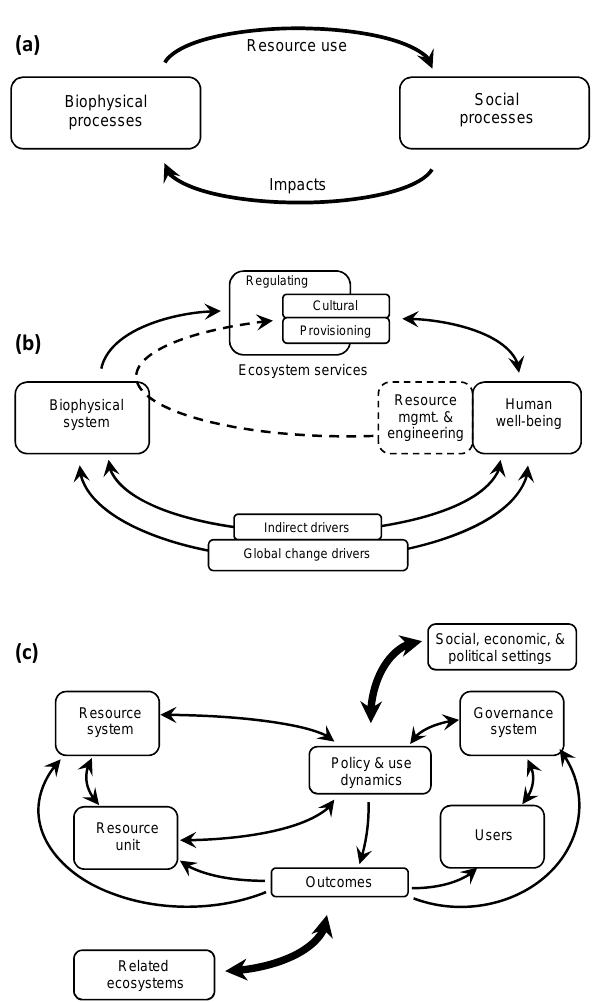
Fig. 1. Schematic diagrams of coupled human-environment sys- tems, illustrating feedback among components in the biophysical and social domains. In each schematic, the left-to-right placement of components reflects their representation of biophysical or social variables. (a) System in its most abstracted form. (b) Millennium Ecosystem Assessment schematic of human-environment system, modified from Carpenter et al. (2009), showing ecosystems services as critical interface between domains and drivers impacting both domains. Role of management and engineering (dashed arrows) added by authors. (c) Social Ecological System (SES) schematic of human-environment system, used by Ostrom (2009) to character- ize social ecological dynamics revolving around a specific natural resource (redrawn by